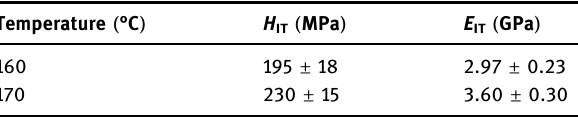
Table 2: Nanoindentation hardness ( H IT ) and Young ’ s modulus ( E IT ) for Arboblend V2 Nature samples made at two